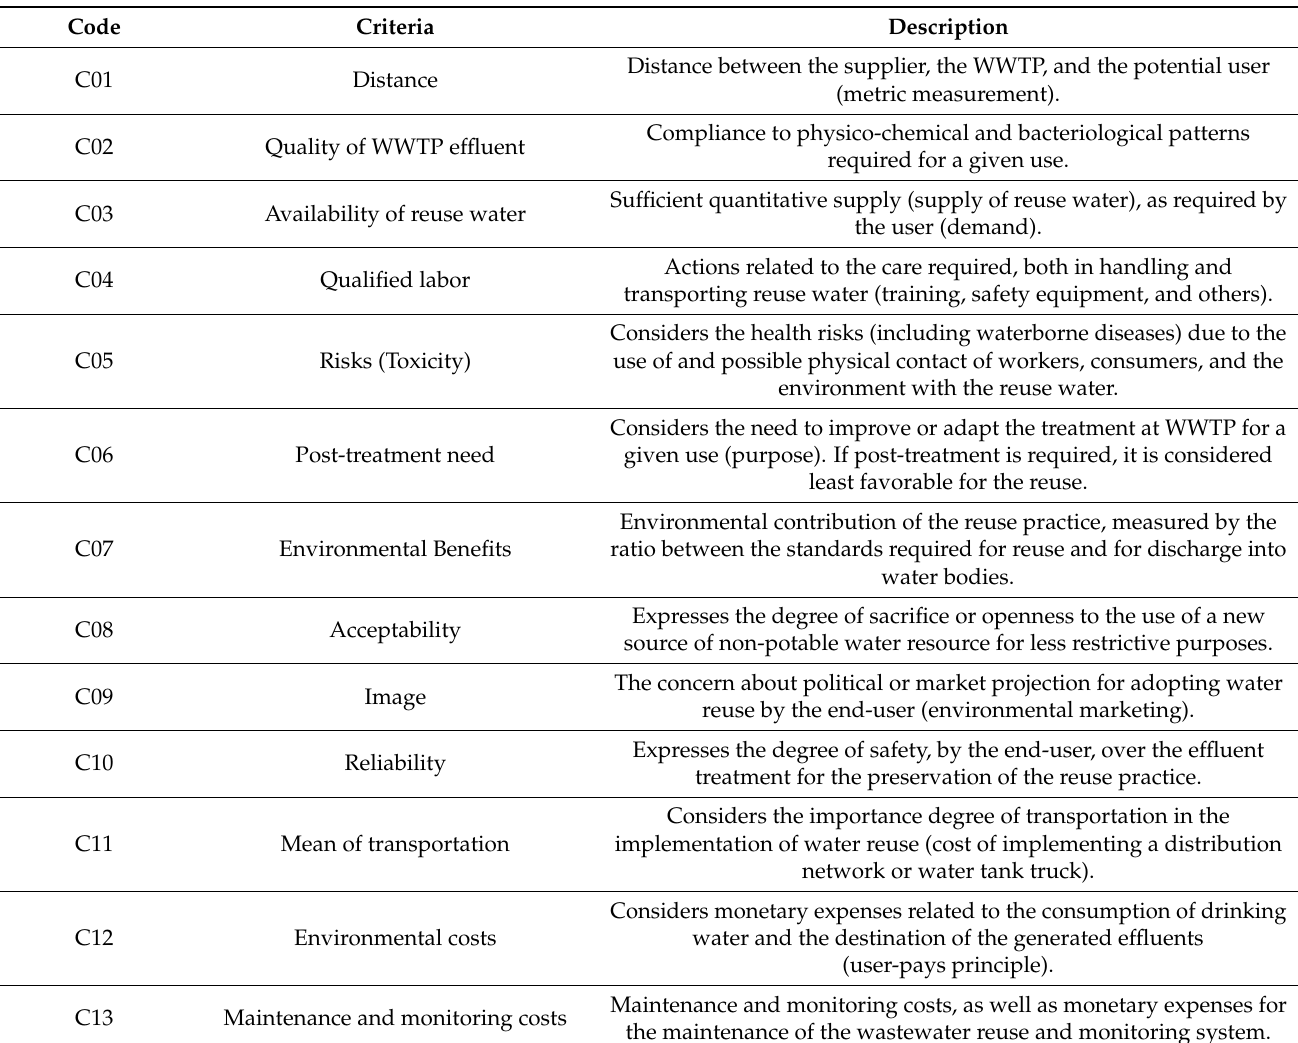
Table 4. Description of the criteria identified to analyze the potential for reuse of WWTP effluent reuse for urban–industrial